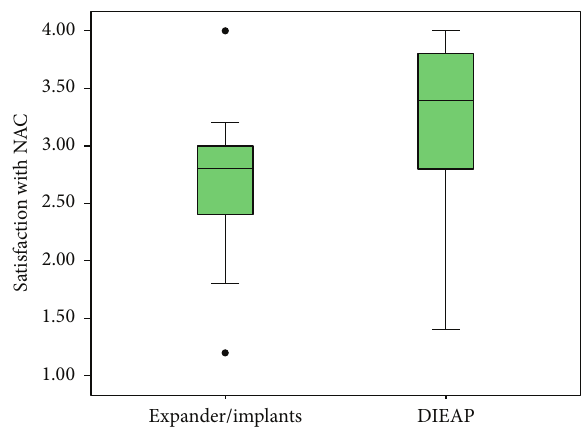
Figure 3: Box plot showing satisfaction with the reconstructed